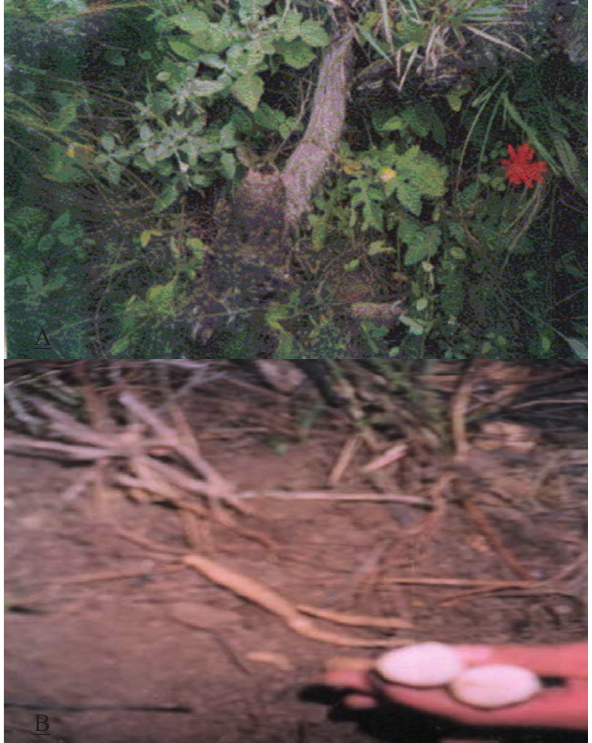
Figure 6. Figure 6: Yacon wild ecotypes: sacha yacón rojo (s.i.) (A) and sacha yacon amarillo ( S. jelksii ) (B). Indicators of in situ conservation of arracacha, yacon and their wild relatives- Six in situ conservation indicators were described for arracacha and yacon: agroclimatic conditions of conservation communities,